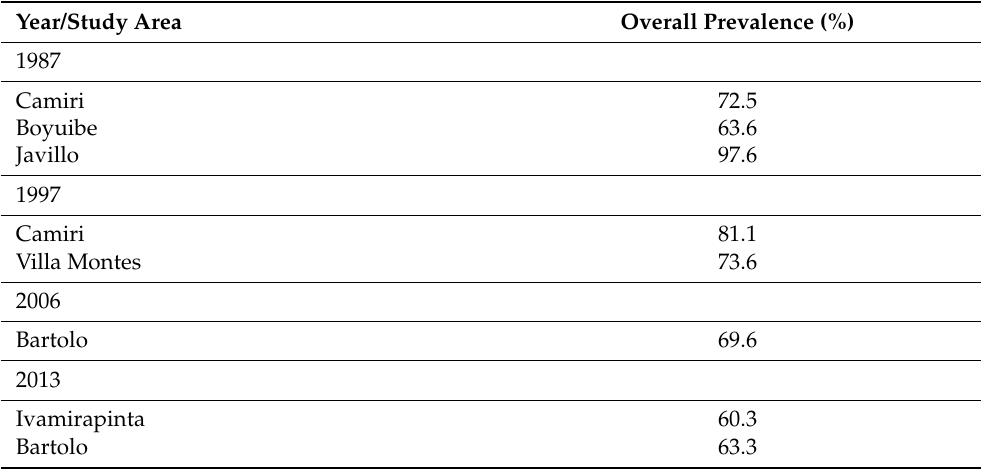
Table 1. Seroprevalence for IgG anti- Trypanosoma cruzi in the human population of the surveyed localities in 1987, 1997, 2006, and